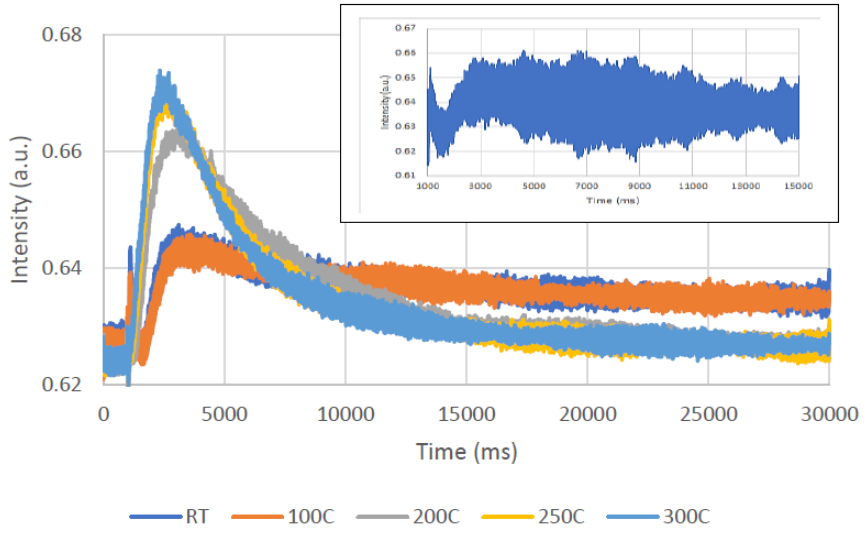
Figure 11. Acetone response to oxygen:acetone/Ar mixture single-pulse experiments at RT, 100, 200, 250, and 300 ◦ C over the 5 mg catalyst. Inset: Acetone response at RT.